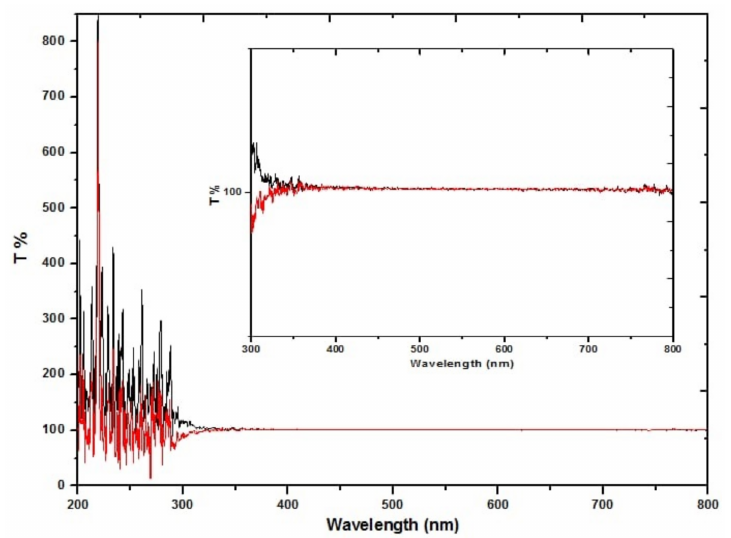
Figure 6. Spectrometer samples test result.